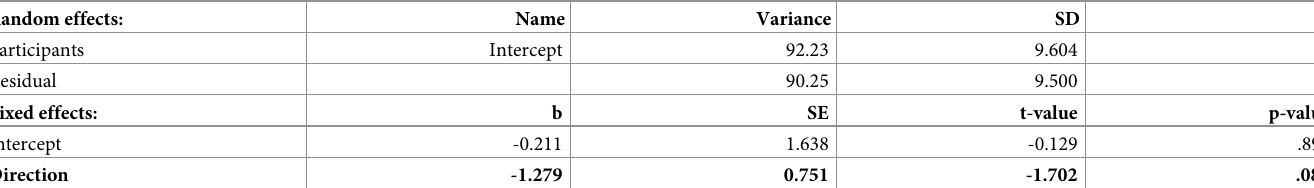
Table 8. Model 2.2. Main effect of Direction on grip force in the time window 620–800 ms (Experiment 2).